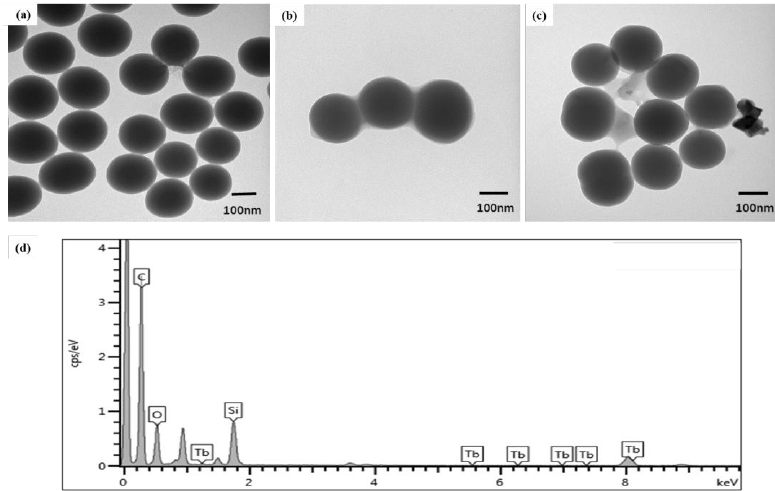
Figure 4. Transmission electron microscope (TEM) images of ( a ) SiO 2 nanoparticles (NPs), ( b ) SiO 2 – TEG, and ( c ) SiO 2 @Tb 3+ (PET–TEG) 3 Phen; and scanning electron microscopy (SEM)-EDS image ( d ).